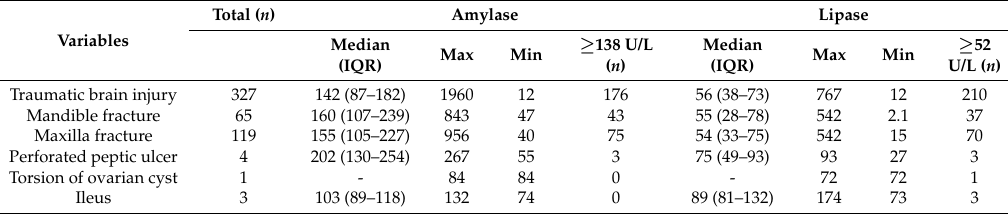
Table 3. Serum amylase and lipase levels of patients with an associated injury or